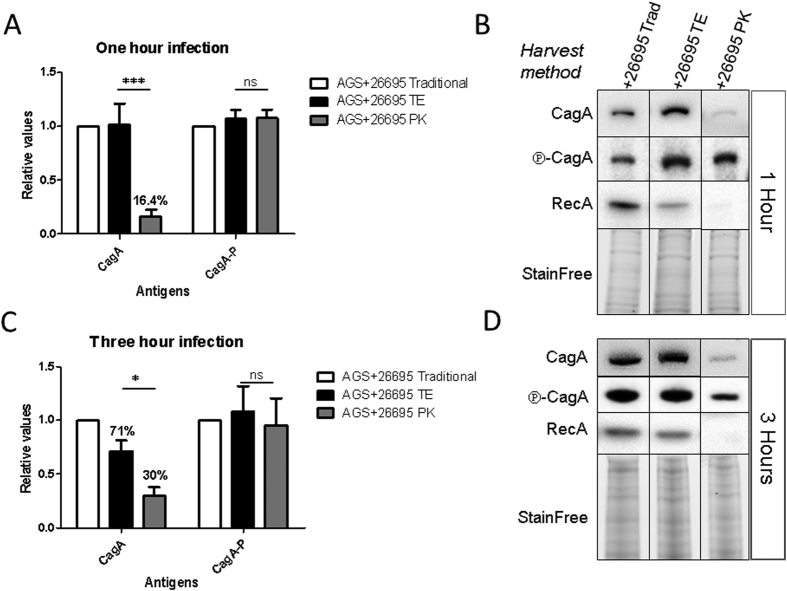
Quantification of signals for phosphorylated CagA (-CagA) and CagA.Infection times were chosen for 1 hour (A,B) or 3 hours (C,D). Densitometry analysis of the signals from the immunodetection of CagA and its phosphorylated form -CagA. Signals from traditional harvest by scrapping (Trad) were used as normalization parameter stabilizing the 100% of the signals to be obtained. Signals obtained from samples digested Trypsin EDTA and Proteinase K are shown relative to the traditional harvest. Single examples of the blots for each time point are shown as well (B,D). All densitometry values were normalized to the Stain Free signal.